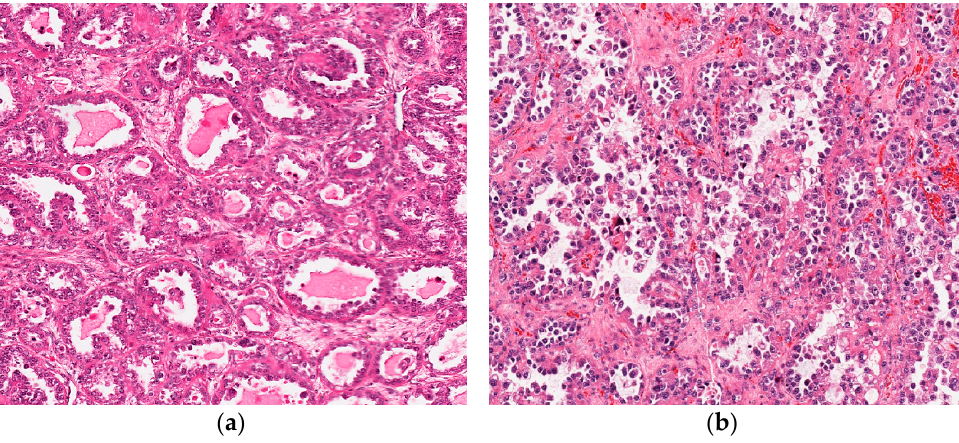
Figure 7. ( a ) Clear cell carcinoma with tubulocystic pattern (hematoxylin-eosin; x200). ( b )